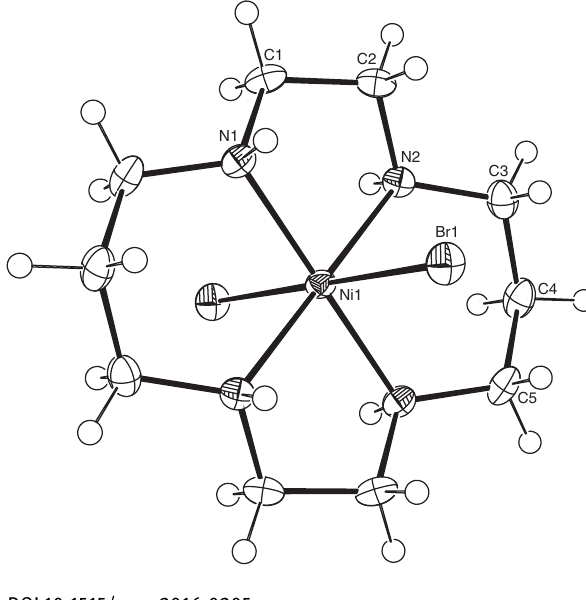
Table 1: Data collection and handling.